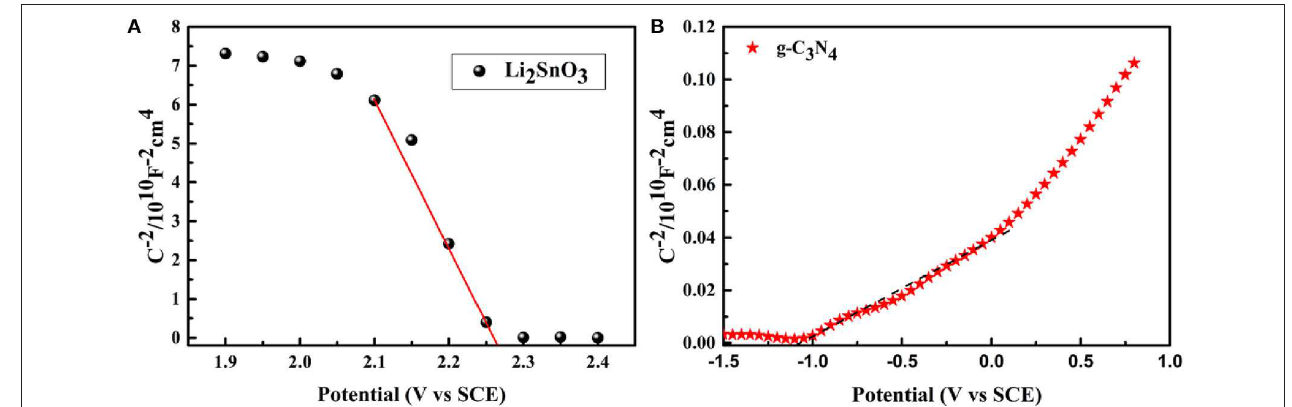
FIGURE 7 | Mott-Schottky plots for (A) Li 2 SnO 3 and (B) g-C 3 N 4 .